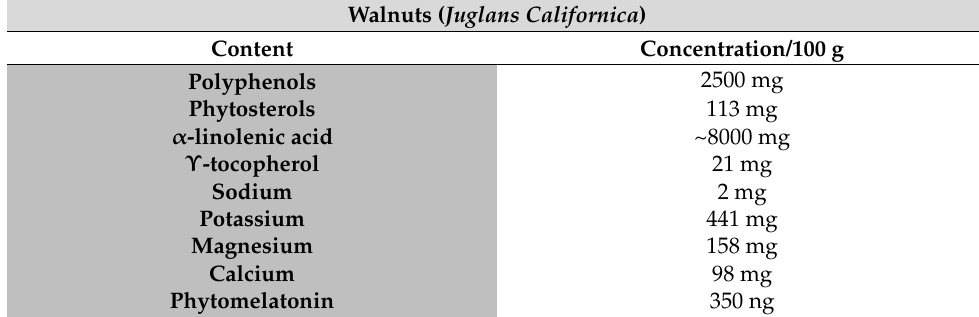
Table 1. Main components of walnuts and biomedical properties